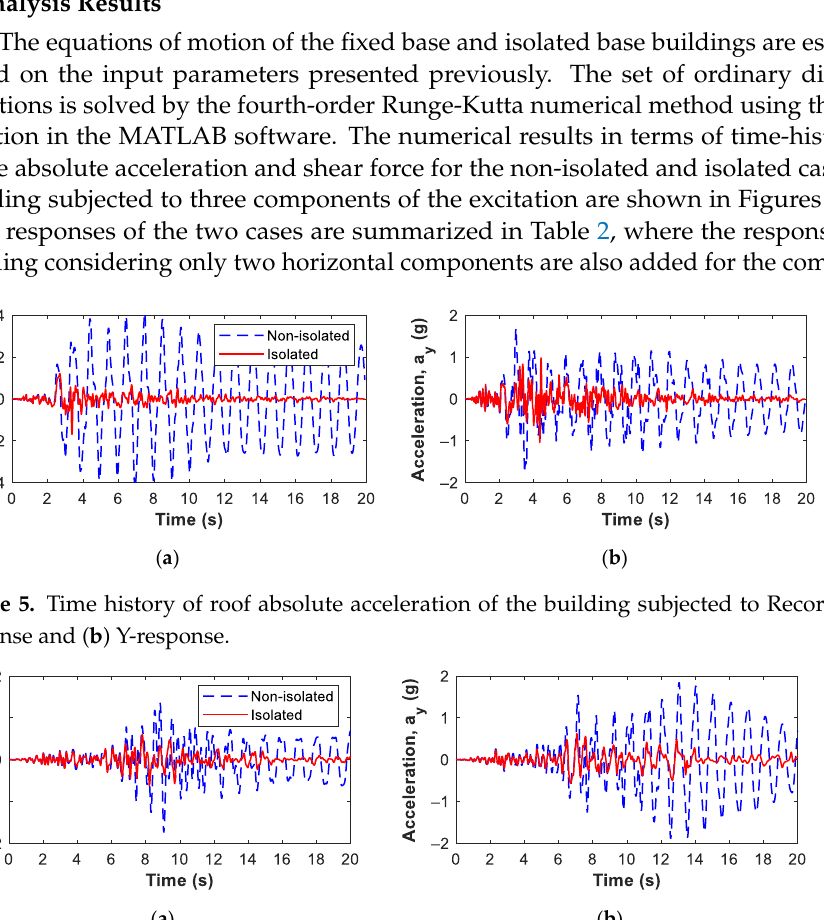
Figure 6. Time history of roof absolute acceleration of the building subjected to Record 2: ( a ) X- response and ( b ) Y-response.